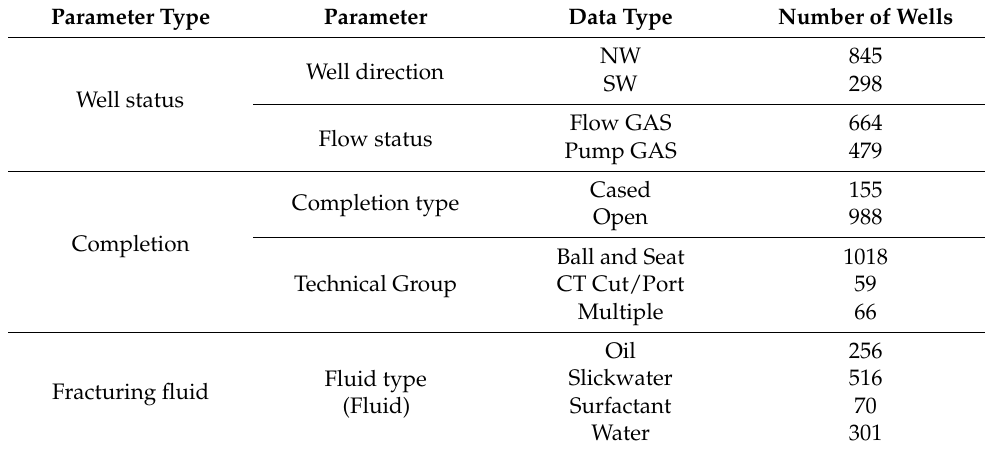
Table 3. Data type and data counts of categorical